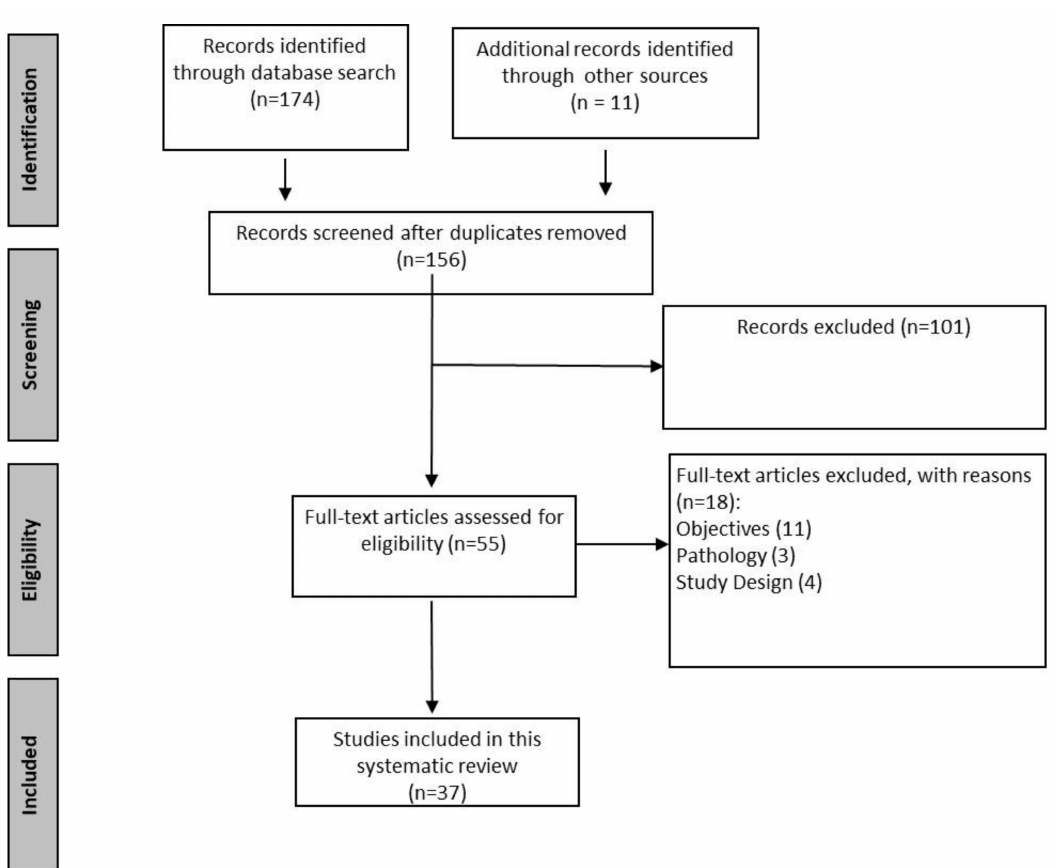
Figure 1. Flow chart summarising the results of the screening process and final article